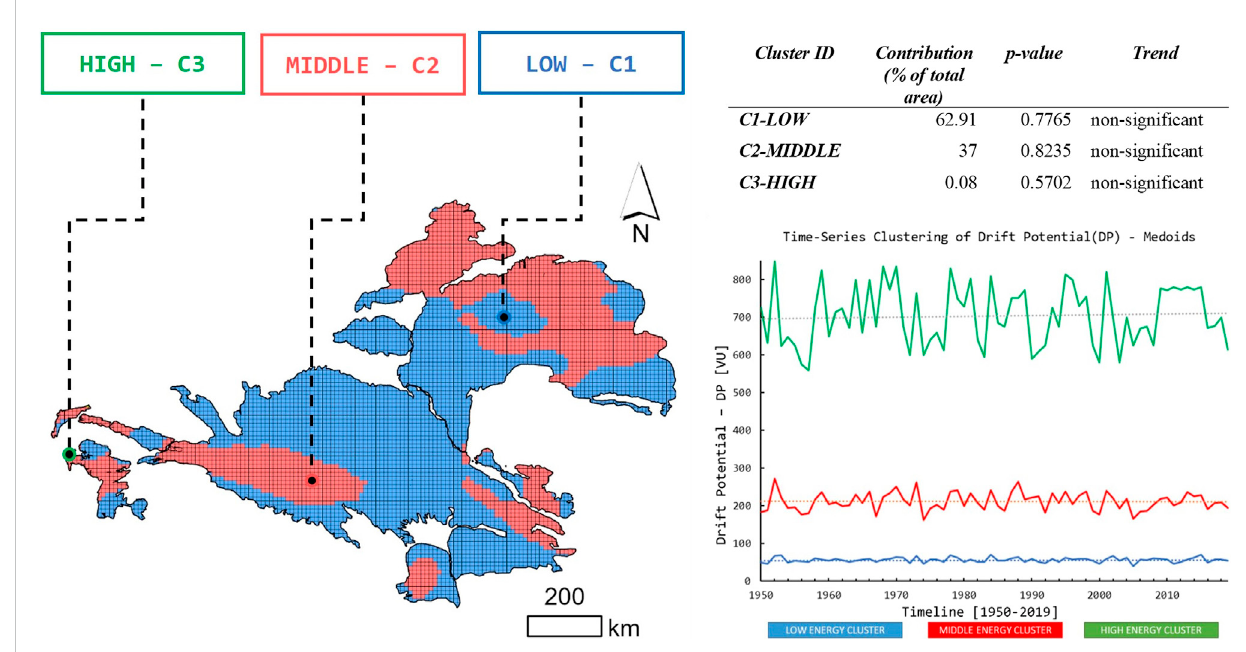
FIGURE 9 Drift potential (DP) time-series PAM clustering, statistical evaluation, and time-series medoids vector for the three clusters calculated in this